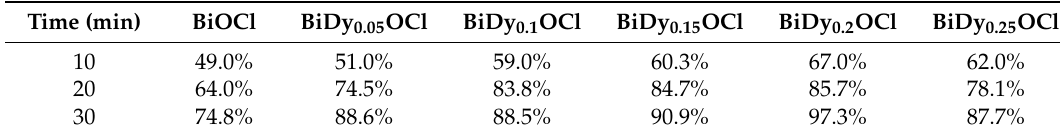
Table 1. The photodegradation ratio for RhB using BiOCl and Dy doped BiOCl samples. A total of